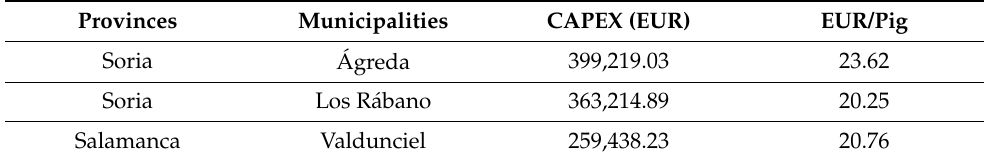
Table 13. Biogas and biomethane operating costs. Provinces OPEX of Biogas (EUR) OPEX of Biomethane (EUR)